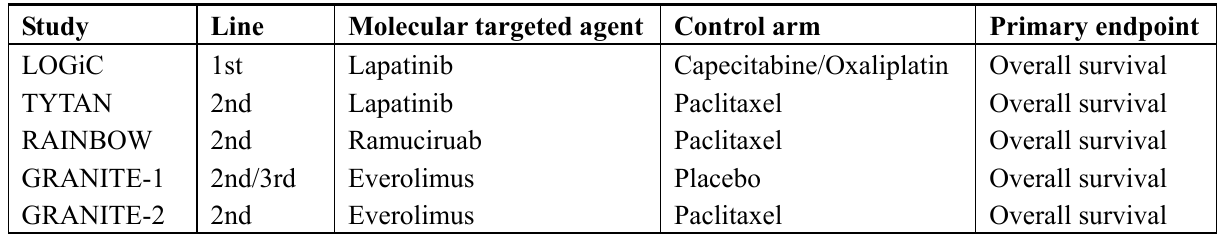
Table 2. Ongoing phase III clinical trials of molecular targeted agents in gastric cancer.